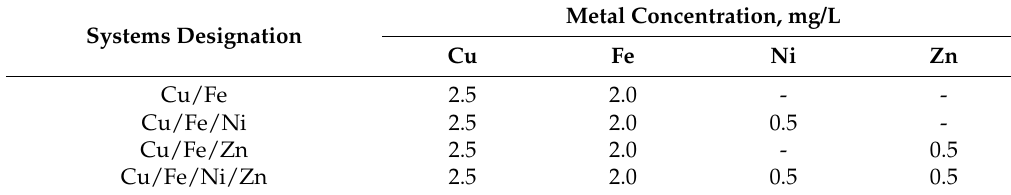
Table 1. Metal concentrations in the studied multielement systems.